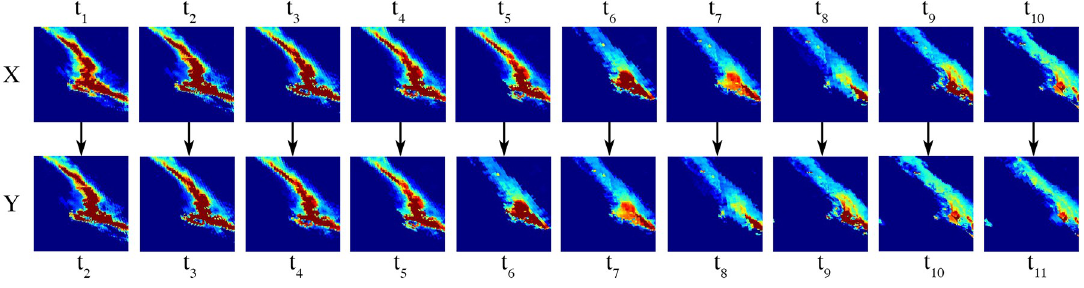
Fig 2. Each timestamp X < t > gets the label of the next consecutive timestamp X < t +1 > for prediction.